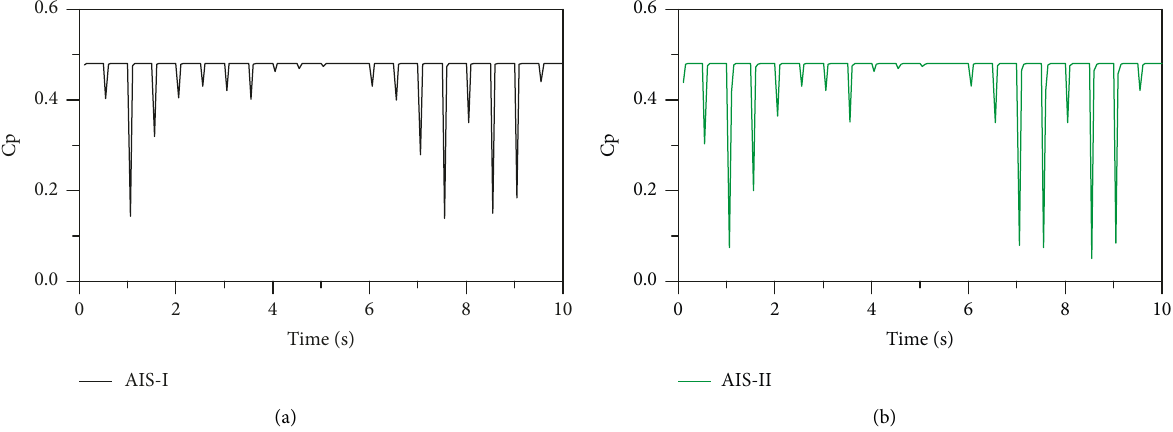
Figure 15: Power coefficient C